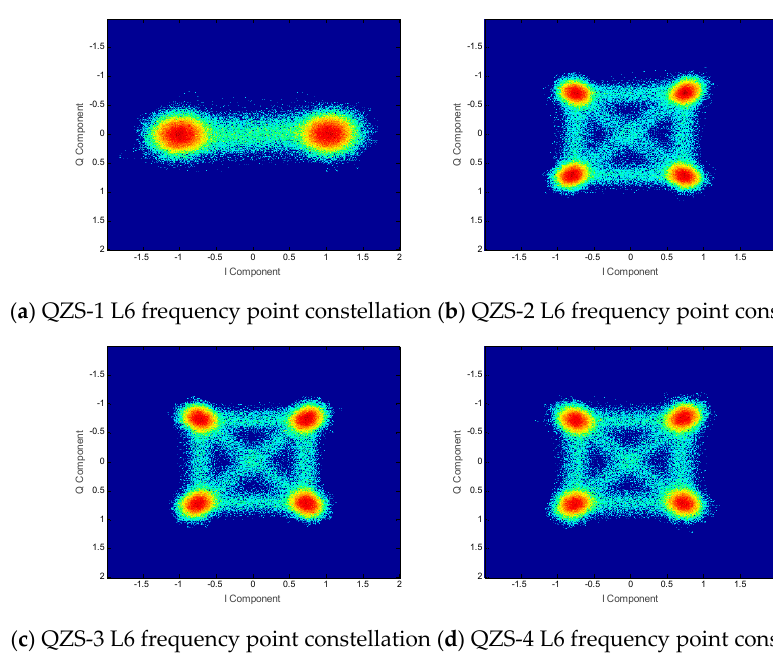
Figure 9. QZSS satellite L6 frequency constellations.